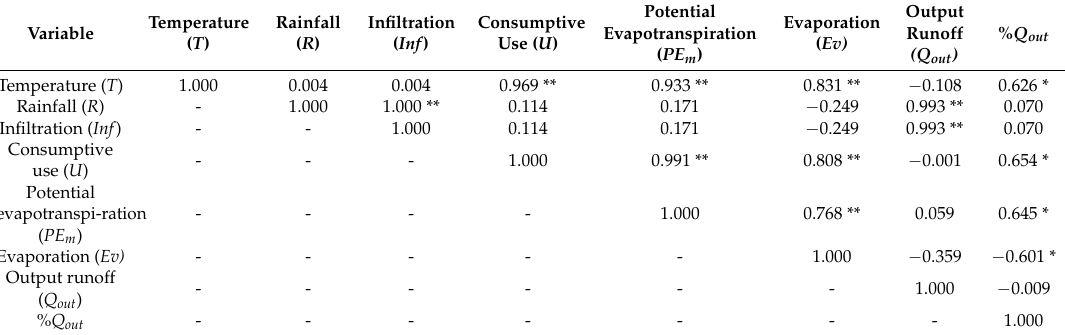
Table 4. Diagonal matrix of Pearson correlations ( r ) of the hydrological variables of 2010.